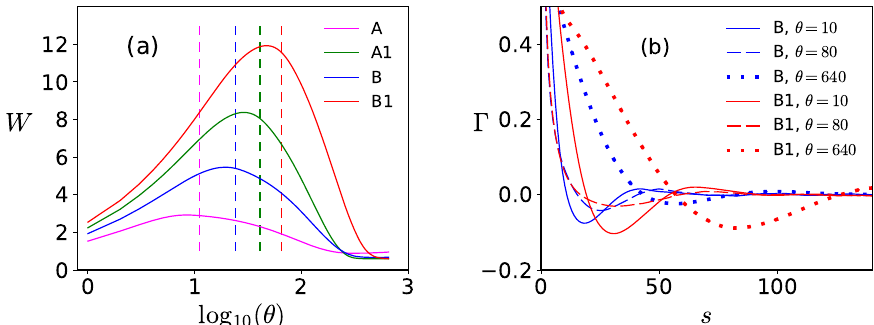
Figure 3. Roughness ( a ) and autocorrelation function ( b ) of films grown in simulations with negligible ES barrier. In ( a ), θ c of all sets are indicated by dashed vertical lines. All lengths are in units of the lattice